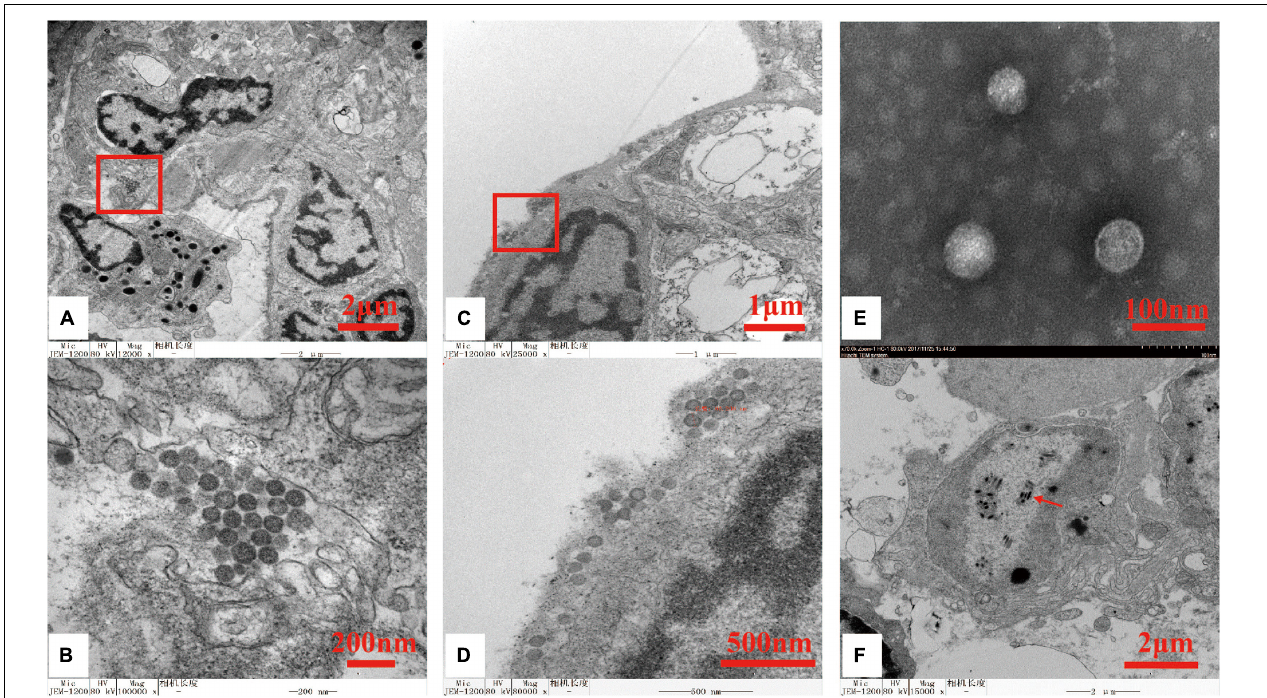
FIGURE 1 | Transmission electron micrographs of oriental wenrivirus 1 (OWV1) and white spot syndrome virus (WSSV) virions. (A) Section of the lymphoid organ, bar = 2 µ m; (B) high magnification of the lymphoid organ section shows the accumulation of OWV1 particles, bar = 200 nm; (C) section of gill, bar = 1 µ m; (D) high magnification of the gill section shows the presence of OWV1 virions, bar = 500 nm; (E) purified OWV1 virions stained with 2% phosphotungstic acid (PTA), bar = 200 nm; (F) TEM of the ultrathin section revealed the presence of rod-shaped WSSV virions (red arrow), bar = 100